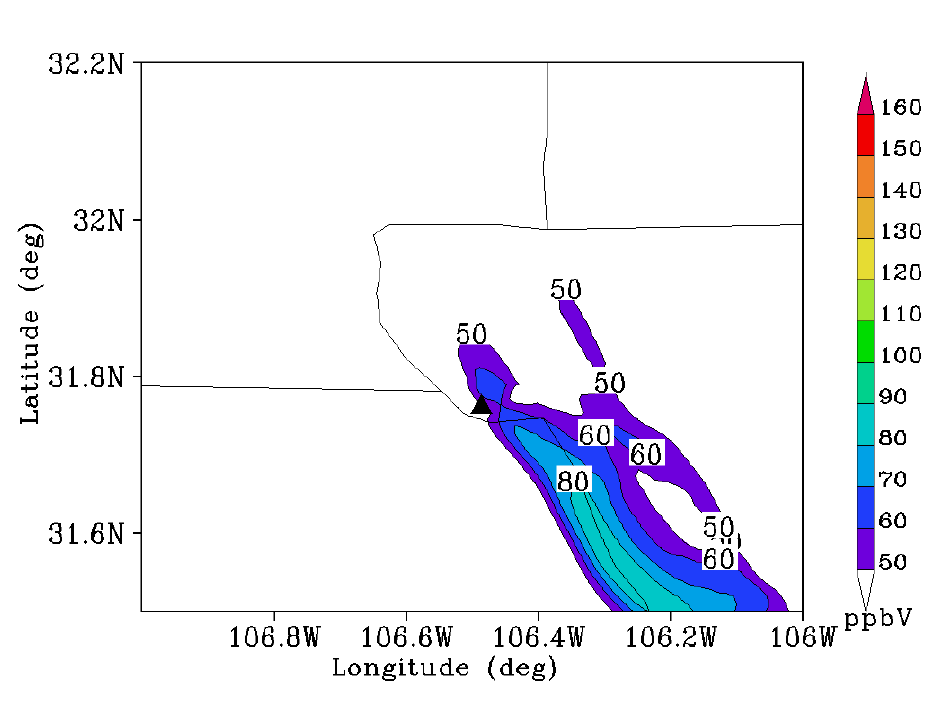
Figure 4. Simulated surface ozone concentration (ppbV) in the fine domain (1km spatial resolution) at (a) 1000 MST, (b) 1200 MST, (c) 1400 MST, and (d) 1600 MST. Black triangle denotes the location of downtown El